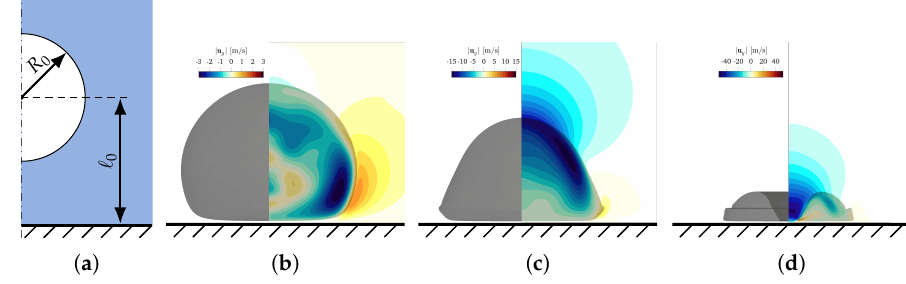
Figure 5. Wall-bounded cavitation. ( a ) Simulation setup. ( b – d ) Instantaneous bubble shape and velocity contours of a bubble with γ = 0.59 and R max = 388 µ m at times t = 39.0 µ s, t = 70.5 µ s and t = 85.0 µ s, respectively. The wall is explicitly illustrated in all